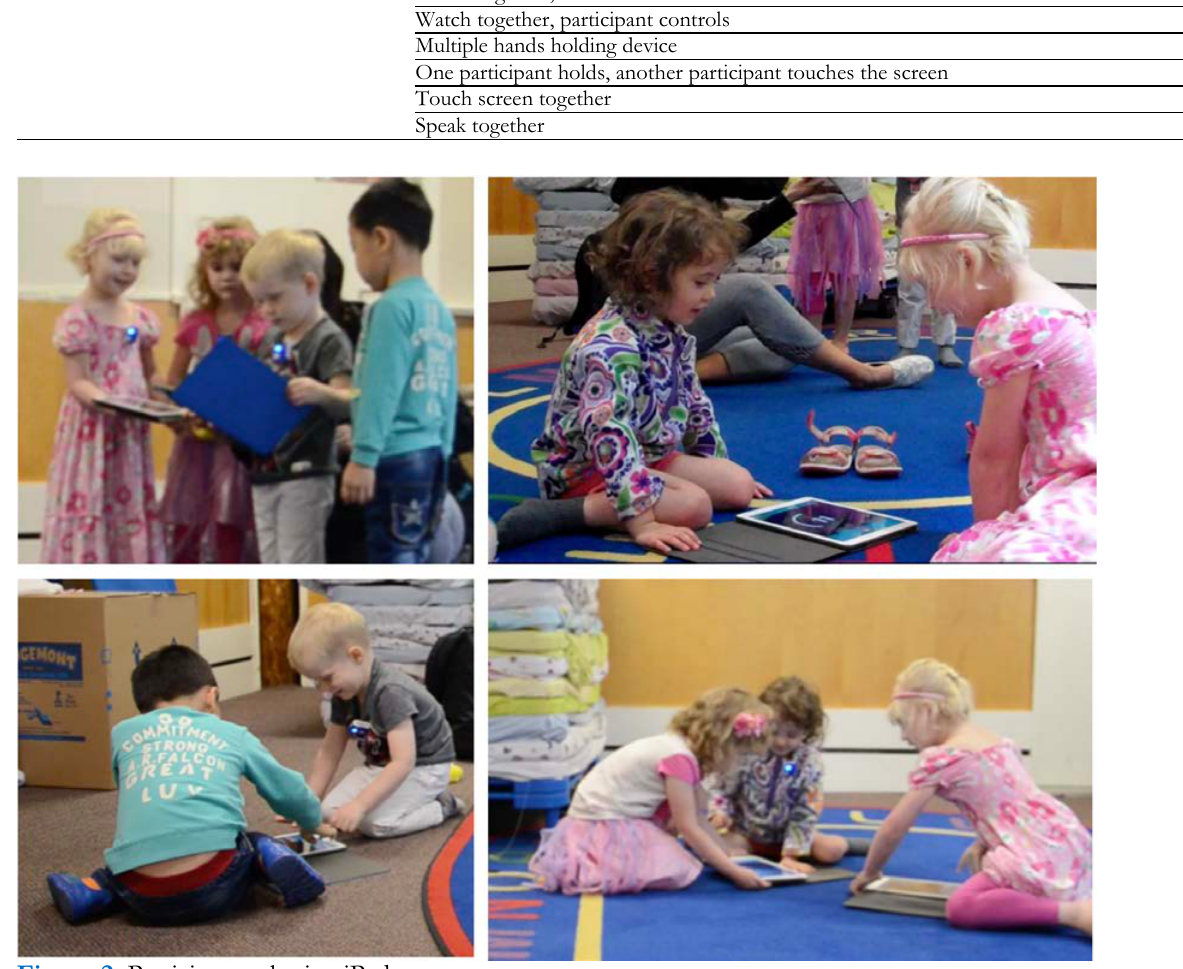
Figure 2. Participants sharing